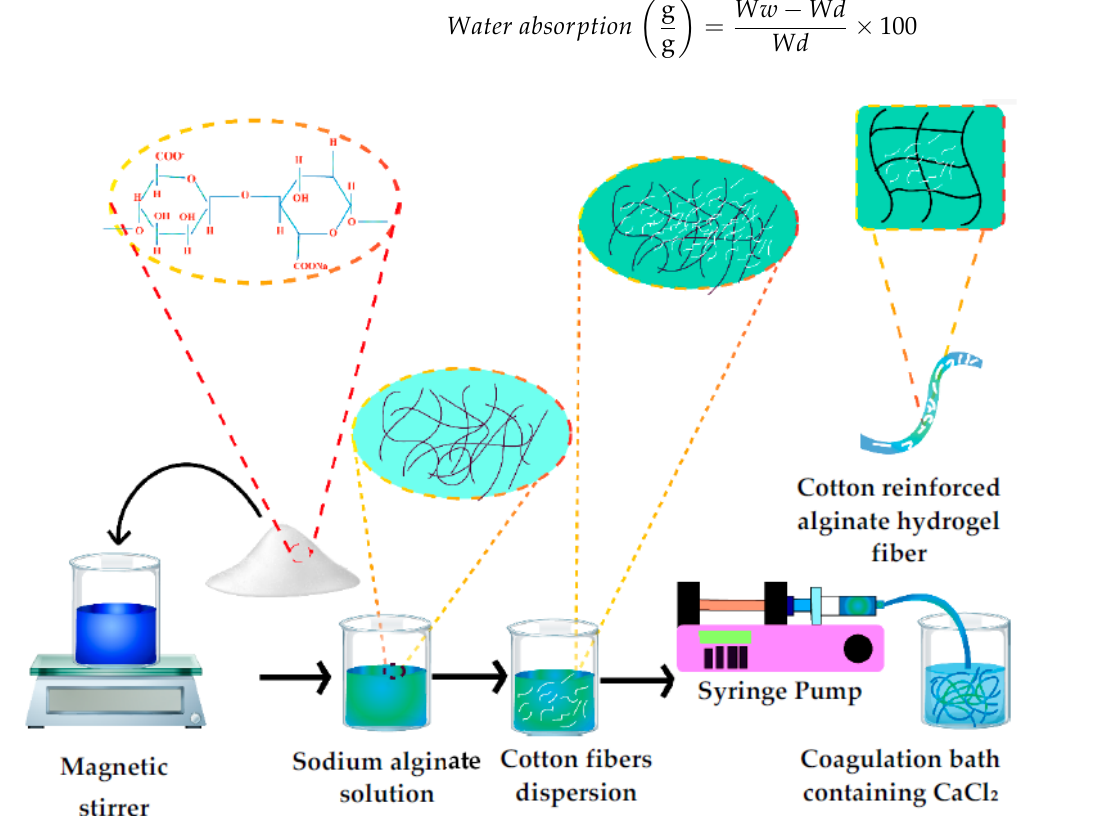
Figure 2. The schematic diagram for the synthesis of cotton-reinforced alginate hydrogel fibers.